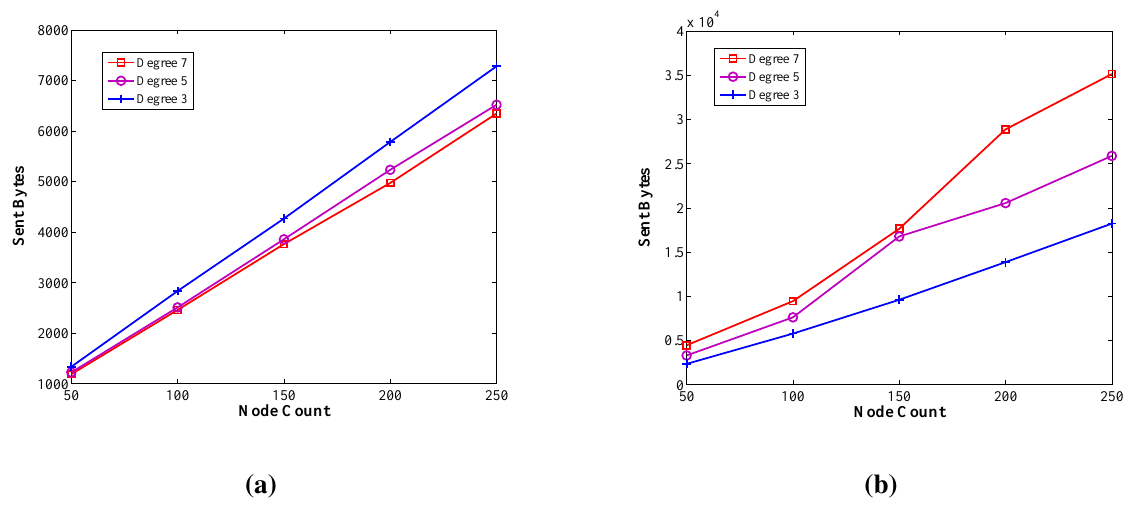
Figure 12. Sent bytes of ABIDE and E-MILIC algorithms against node count and degree. ( a ) Sent bytes of ABIDE; ( b ) sent bytes of E-MILIC.